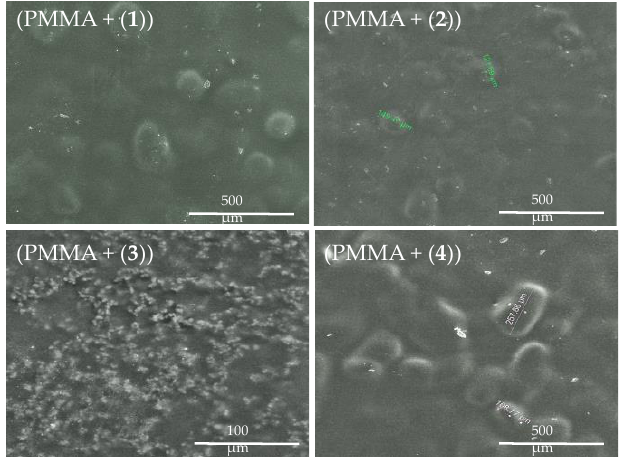
Figure 4. SEM images of poly(methyl methacrylate) (PMMA) + TOCs and TOCs = ( 1 )–( 4 ) composites dispersed in the PMMA matrix.